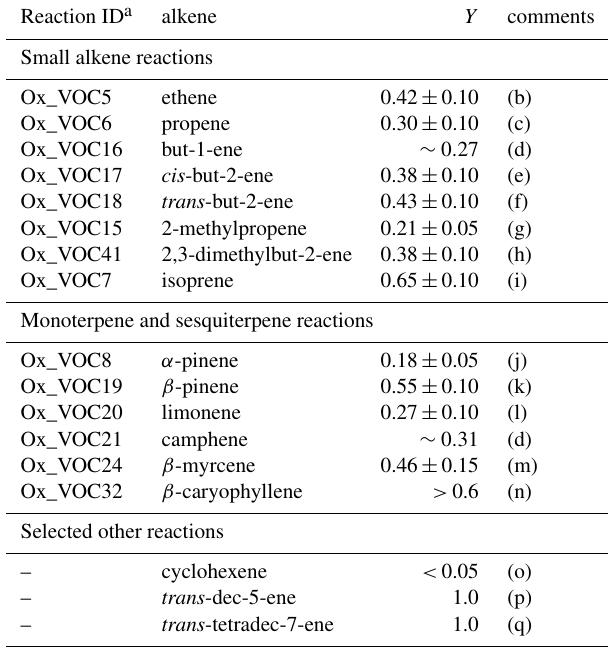
Table 2. Summary of recommended total sCI yields ( Y ) from O 3 + alkene reactions at 298K and 1bar.